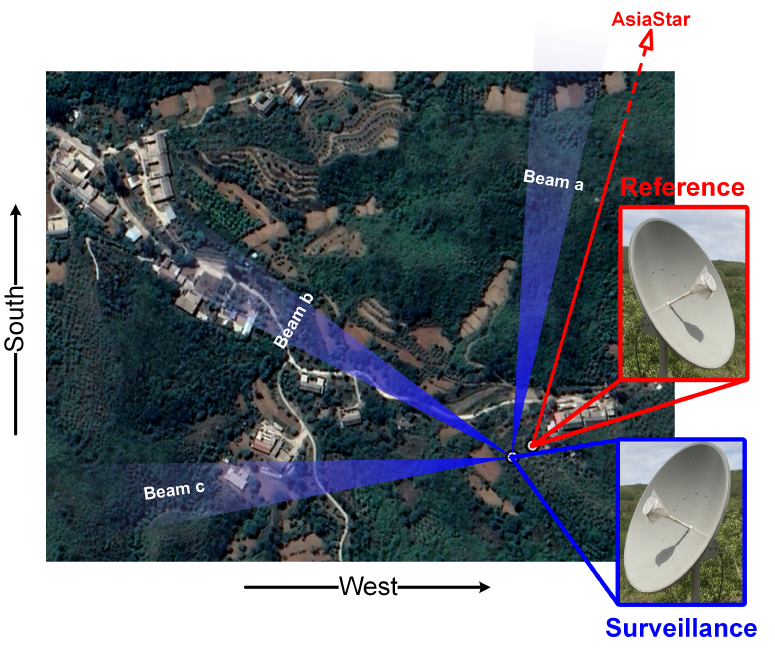
Figure 7. The geometry configuration of the experiments: The surveillance and reference antennas are marked in blue and red, respectively. The direction of AsiaStar is indicated with a red arrow. Three surveillance beams, denoted with “Beam a/b/c”, of different azimuths were used during the